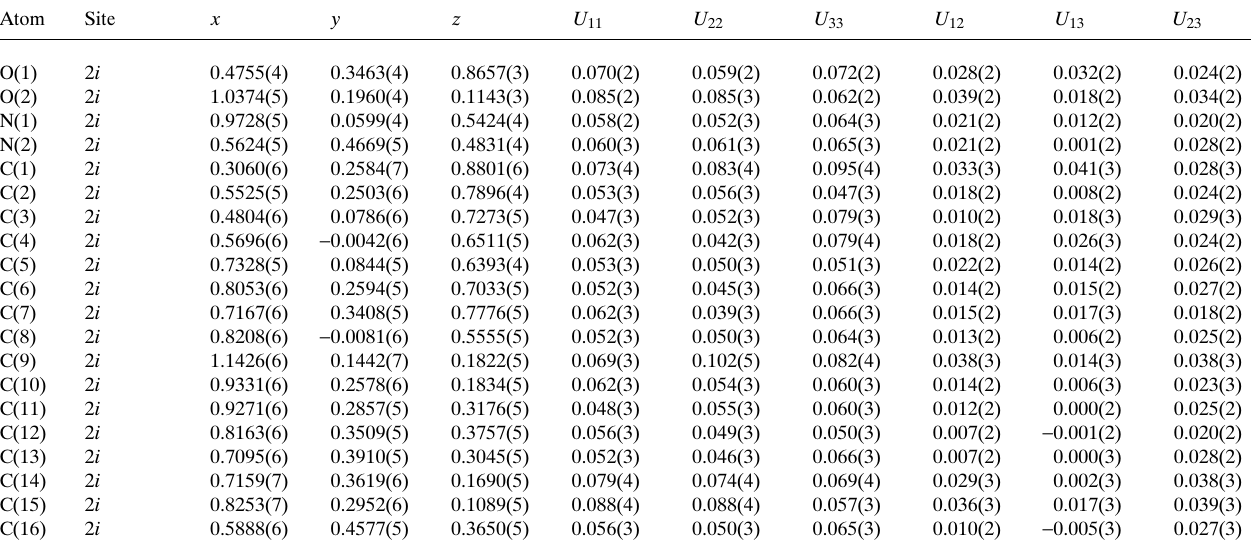
Table 3. Atomic coordinates and displacement parameters (in Å 2 )